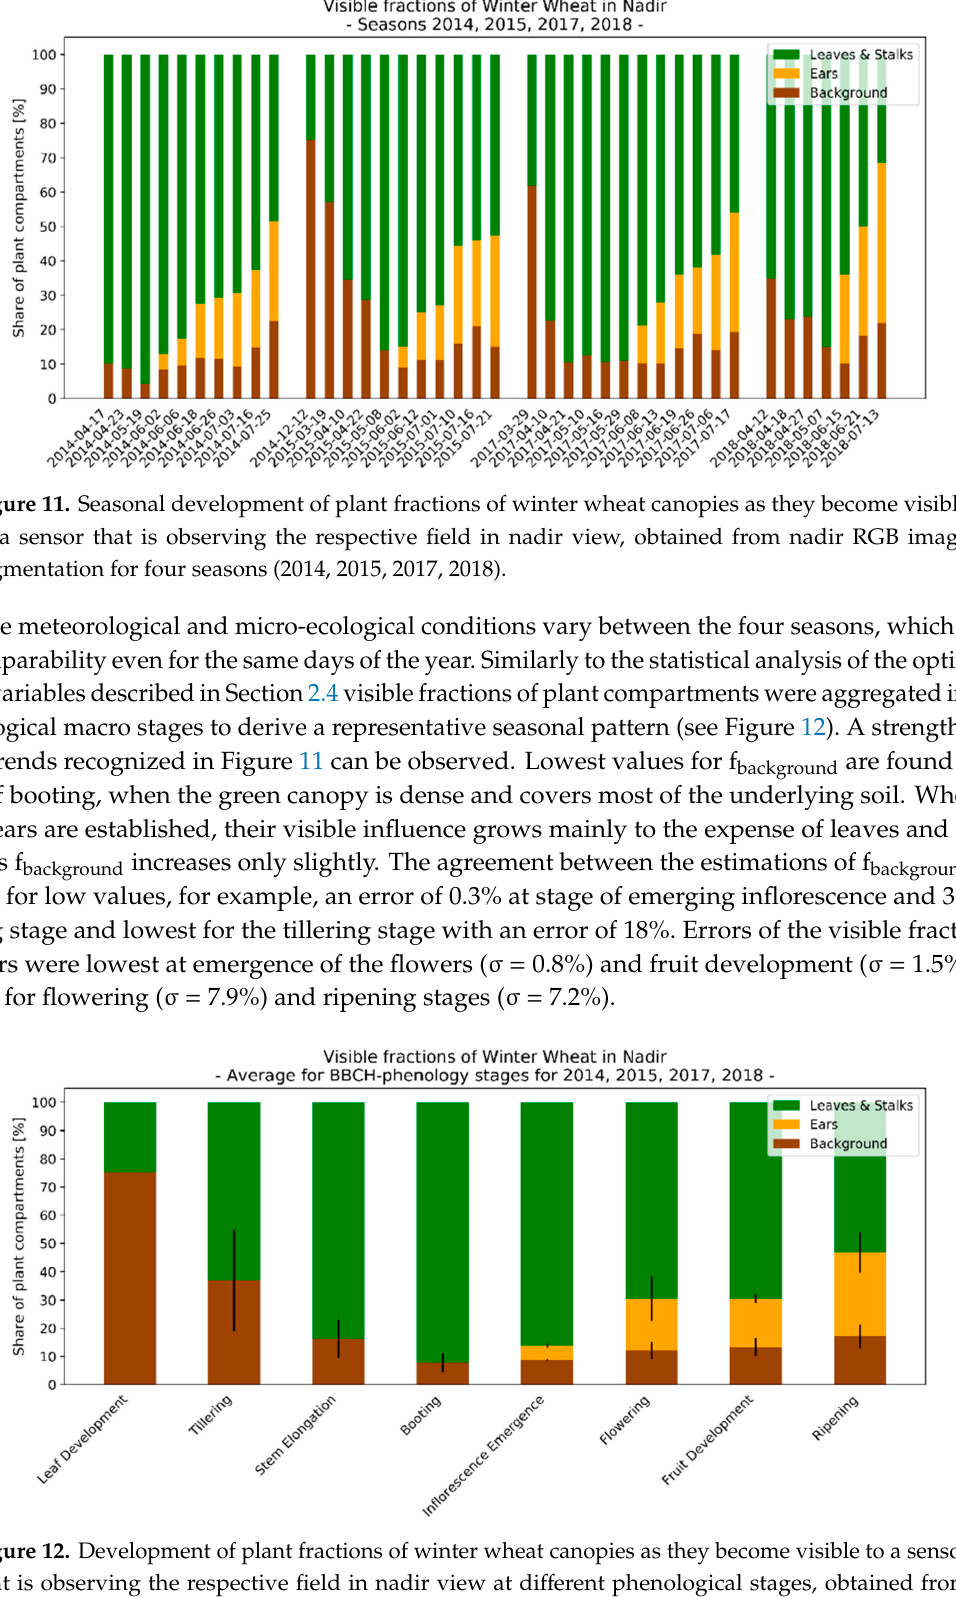
( b ) Figure 13. Dependency between the fraction of visible ears (f ears ) and the RMSD of spectral measurement vs. PROSAIL output for all winter wheat data ( a ) and aggregated into phenological macro stages ( b ). Standard deviations of the BBCH-aggregation in b are symbolized by vertical error bars. 4. Discussion The performance of the parameter retrieval of canopy reflectance models is usually evaluated by means of descriptive statistics, comparing measured and estimated variables and assuming that